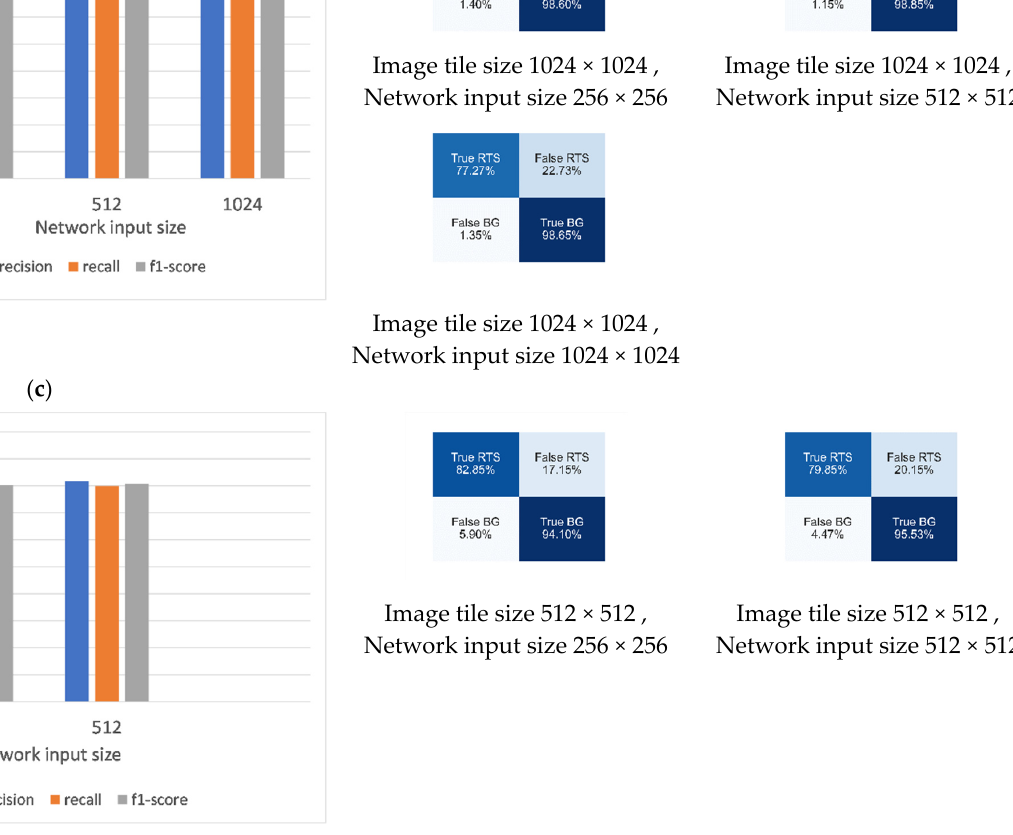
Figure 12. Model test accuracy based on the hand annotated RTS from Banks Island. ( a ) Image tile size of 2048 × 2048 resized to network input sizes of 256 × 256, 512 × 512, and 1024 × 1024. ( b ) Image tile size of 1024 × 1024 resized to network input sizes of 256 × 256, 512 × 512, and without resizing as 1024 × 1024. ( c ) Image tile size of 512 × 512 resized to network input size of 256 × 256 and without resizing as 512 × 512. Bar charts depict accuracy measures of Precision, recall, and F1 score. Corresponding confusion matrix for each of the scenarios shown on the right.